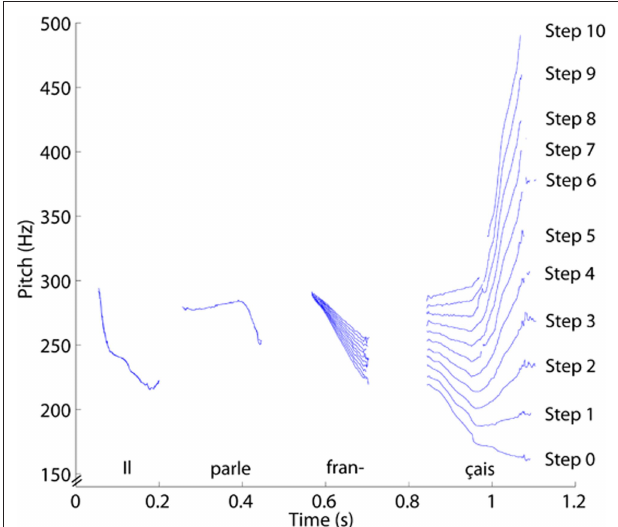
Figure 1 | The fundamental frequency across time for all 11 steps of the sentence “il parle